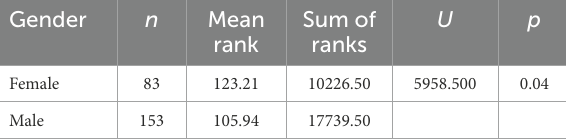
TABLE 2 Mann–Whitney U test results of the coach’s leadership behavior scores by